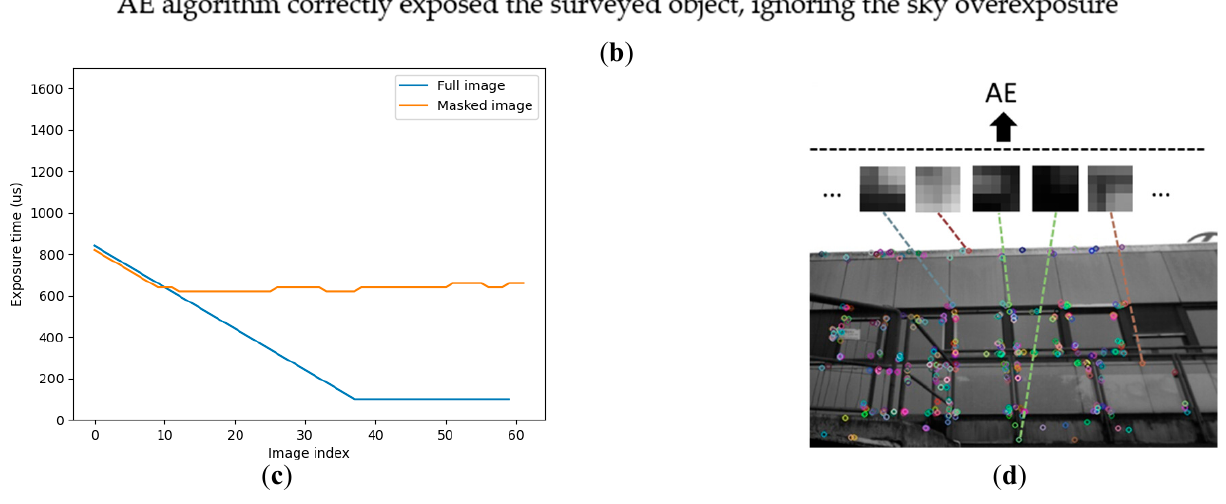
Figure 8. Some of the images acquired when the auto exposure (AE) algorithm uses the whole image ( a ) and the proposed masked image ( b ). ( c ) Plot of the exposure time in the two tests. ( d ) Visualization of the tie-points locations used by the AE algorithm in one of the images.